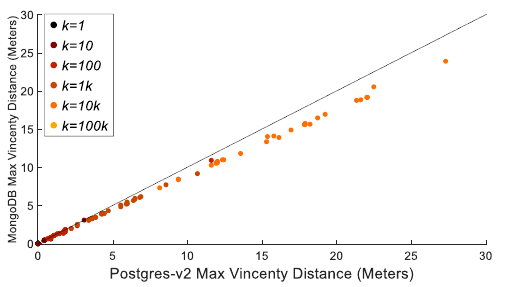
Figure 7 Maximum Vincenty distance up to 30 meters for the whole year Out of the 180 points, 131 of them are below the line. Remaining 49 points are exactly on the x=y line. Interestingly, Postgres-v2 have not found a better result at any query point for any given k value.